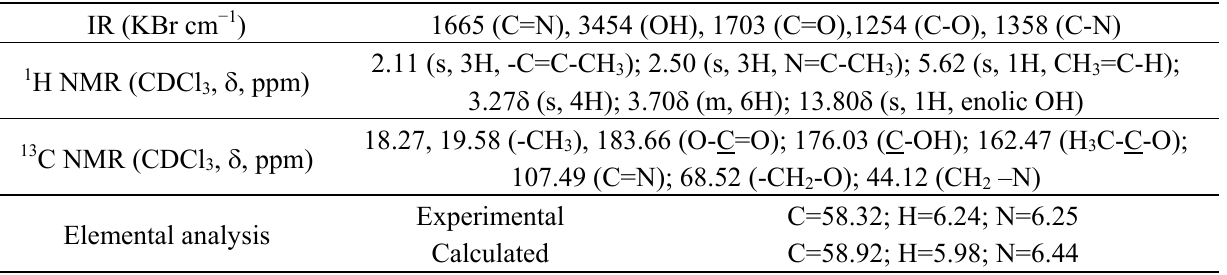
Table 1. IR, 1 HNMR, 13 CNMR spectroscopy data and elemental analysis of SB.